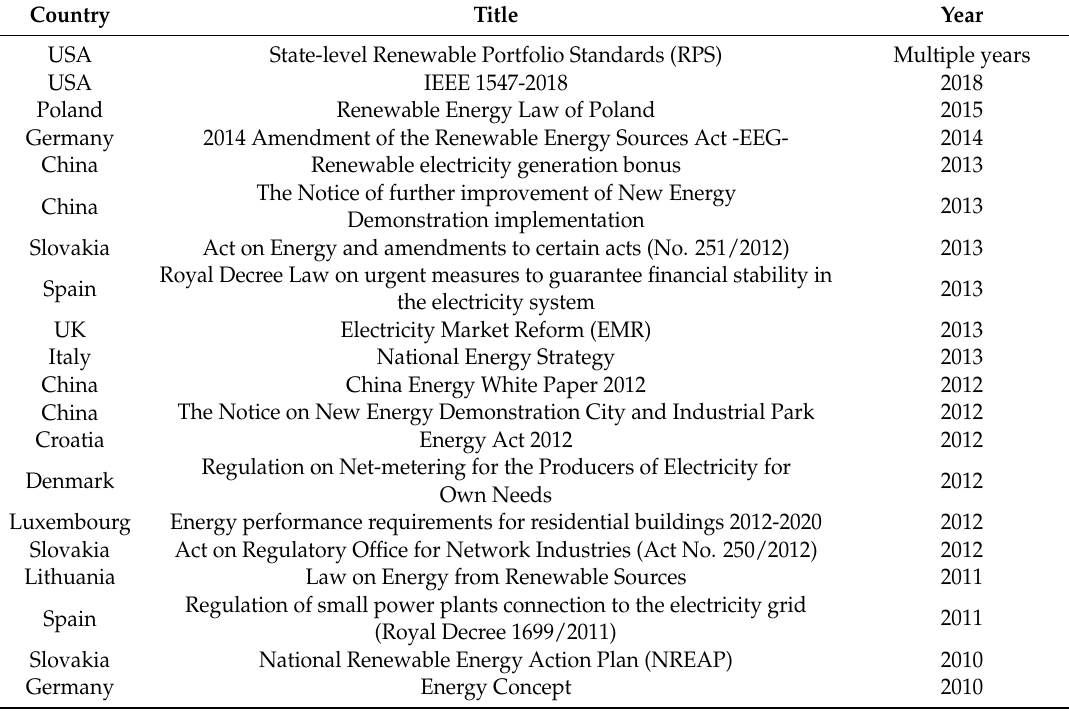
Table 1. Main energy polices for MG development from 2010